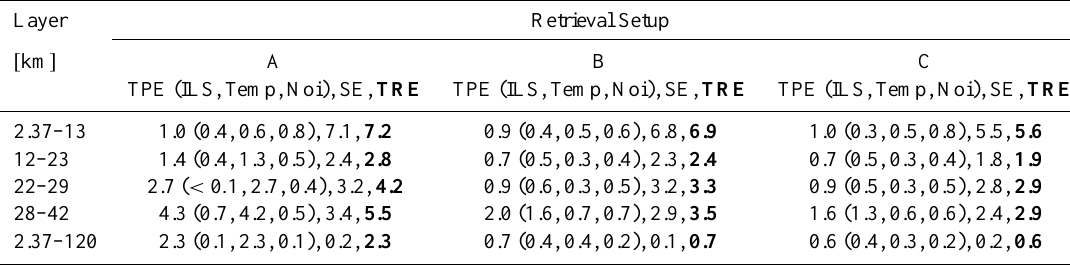
Table 4. Estimated random errors relative to actual ozone partial columns and total column [%] for the Iza˜na IFS 120/5HR for all setups and for the different layers.